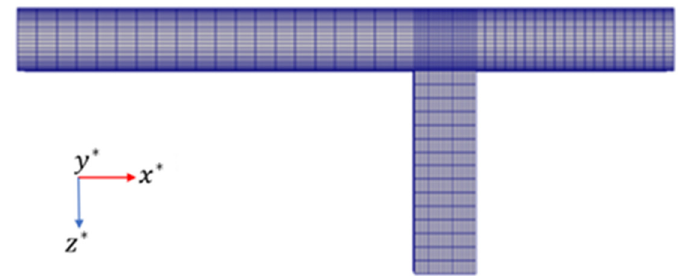
Figure 14. The refined mesh.